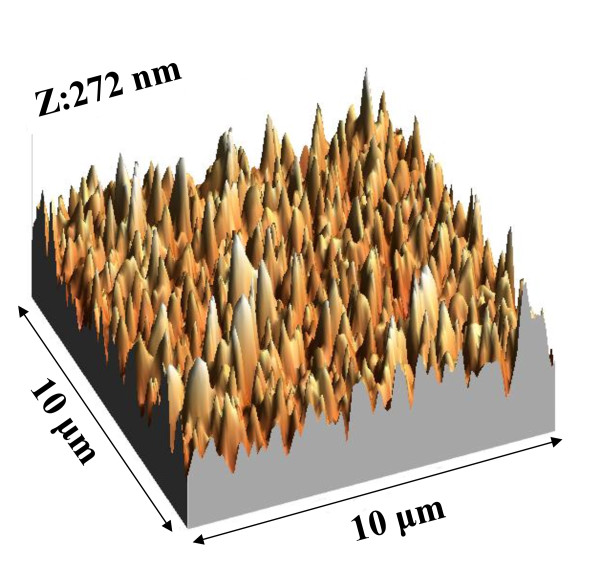
The AFM surface morphology of a-Si:H nanocone. The dimension is 10 × 10 μm2.